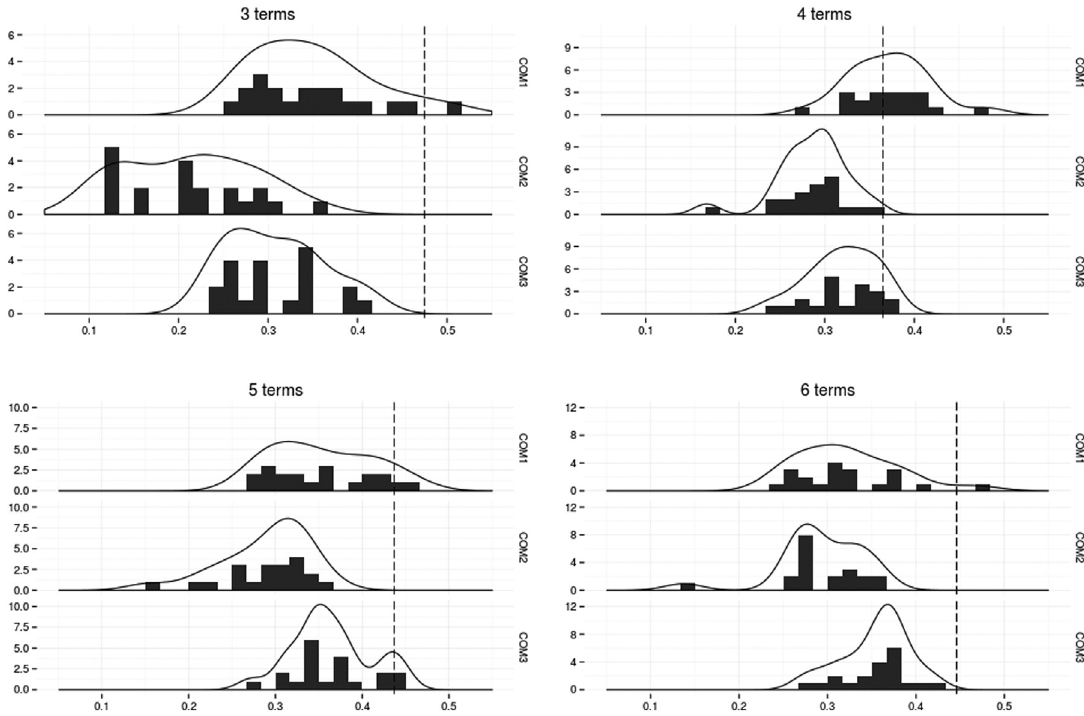
Figure 8: Histogram of maximal similarities for each color-naming scheme of each variant of the model. Solid line corres- ponds to a 1d kernel density estimate as produced with default parameters by the ‘ggplot2’ R package. Dashed line indicates the value obtained by